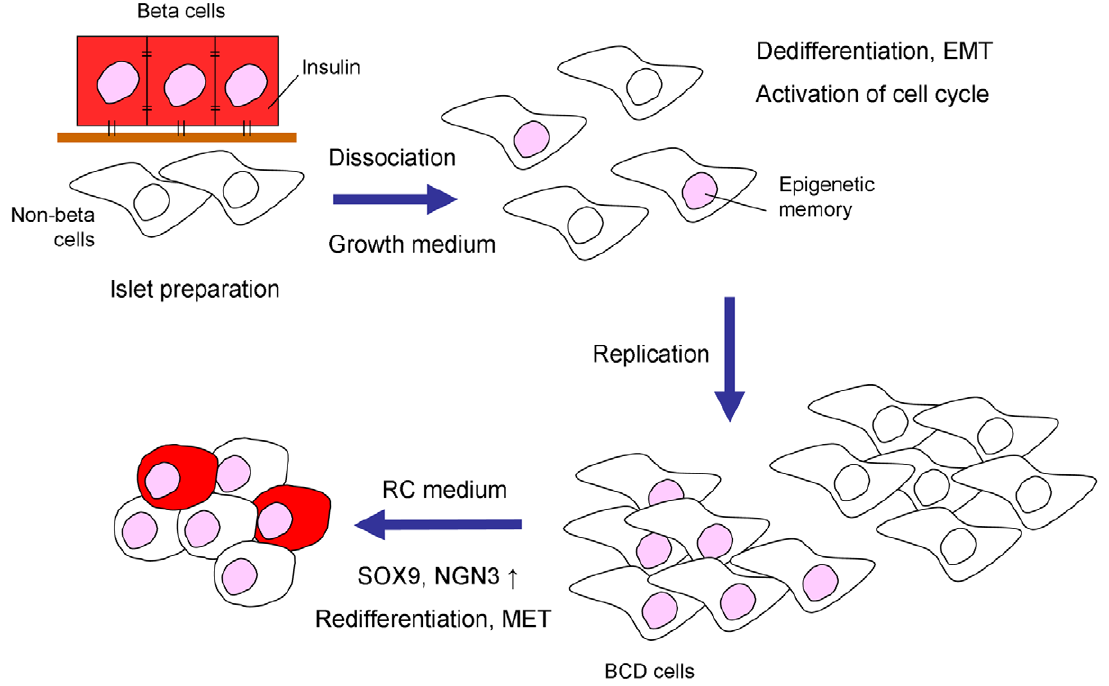
Figure 6. Scheme of beta-cell expansion and redifferentiation. Human islet preparations are dissociated into single cells and cultured in growth medium. Beta-cell dissociation from epithelial structure, and exposure to growth factors, induce EMT and dedifferentiation, but BCD cells maintain epigenetic memory. All cell types in the mixed islet cell culture, of which , 45% are BCD cells, are induced to replicate. Following exposure to RC treatment, , 25% of BCD cells undergo redifferentiation, which is associated with MET and activation of SOX9 and NGN3 expression. De-novo differentiation of non-BCD cells does not contribute significantly to generation of insulin-producing cells.